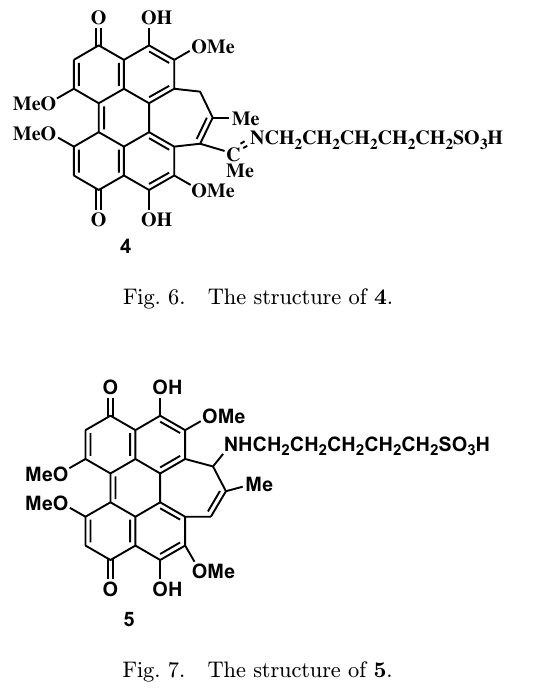
Fig. 7. The structure of 5